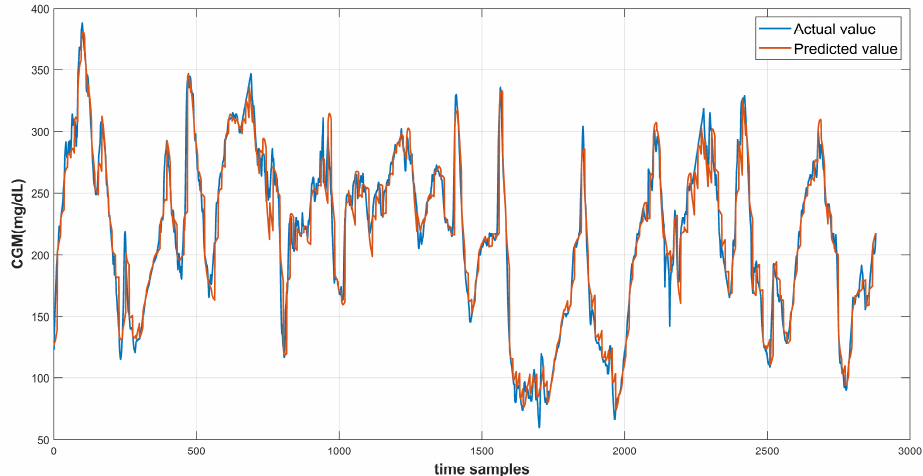
Figure 16. Prediction curve for complete test data of Patient ID